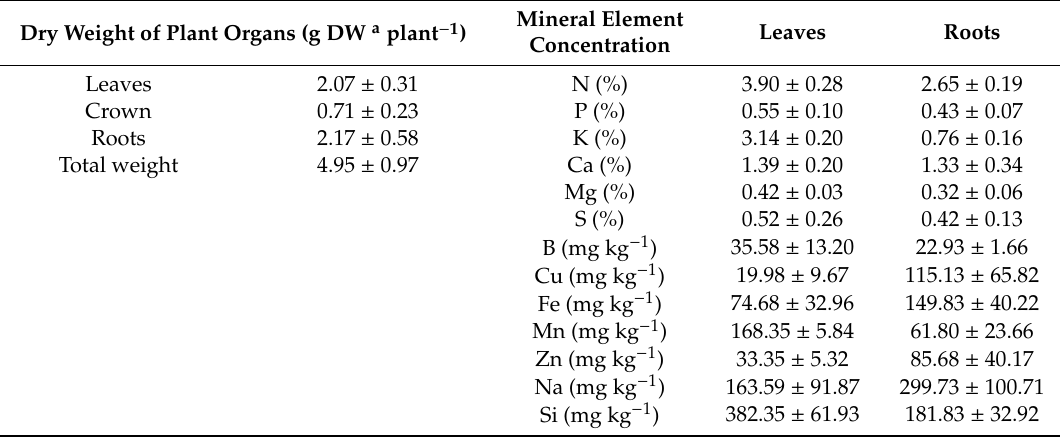
Table 2. Characterization of the cold stored strawberry plants at the transplanting: dry weight of the organs and mineral element concentrations in leaves and